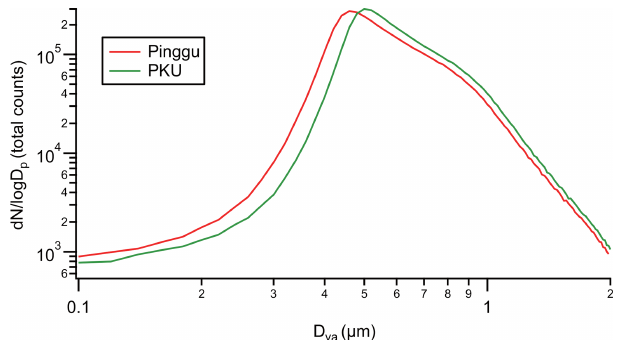
Figure 1. The size distribution of SPAMS particles at PKU and PG